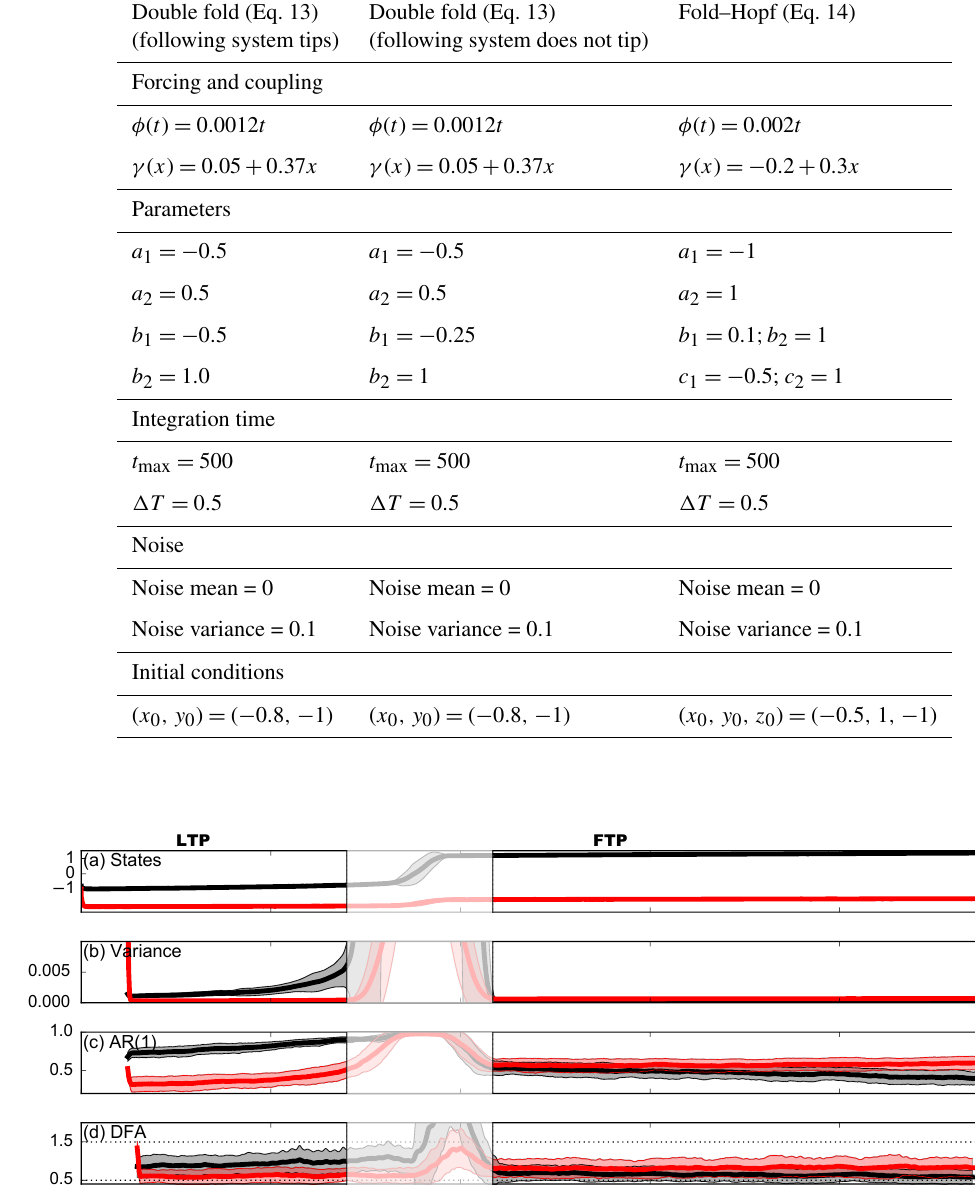
Table 2. Parameter values, coupling and initial conditions for the ensemble simulations of the double Fold and fold–Hopf systems as shown in Figs. 3, 4 and 5.